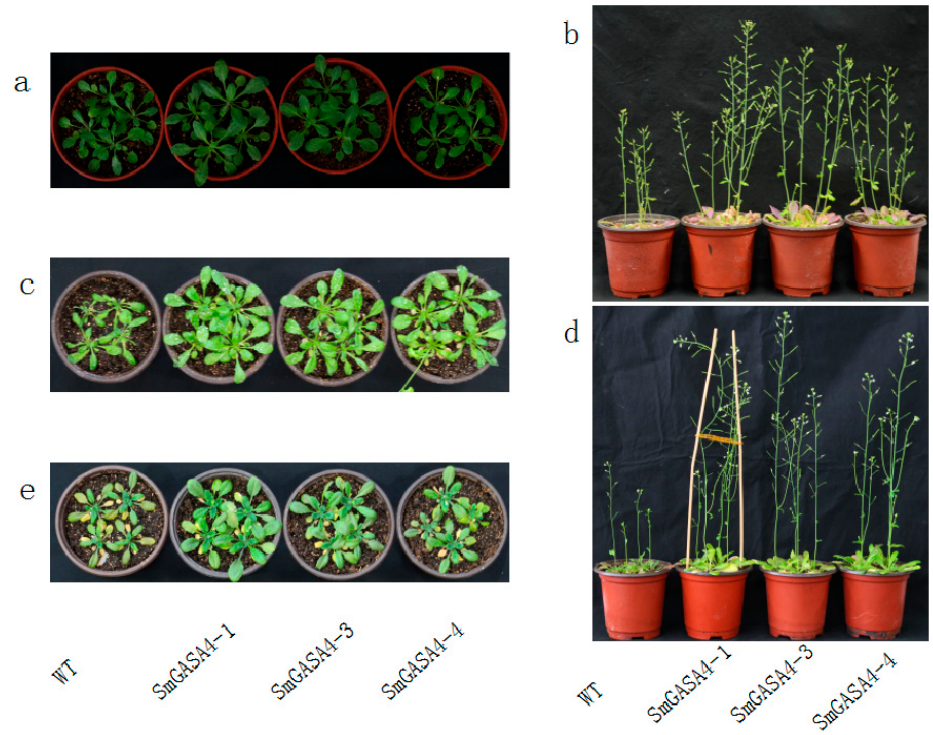
Figure 8. Effects of SmGASA4 overexpression during Arobidopsis stress treatment, as follows: ( a ) Arobidoposis before stress, ( b ) 30 day drought stress, ( c ) 10 day 200 mmol/L NaCl stress, ( d ) 16 day 200 μ mol/L GA3 treatment, and ( e ) 10 day 100 μ mol/L paclobutrazol (PBZ) stress.